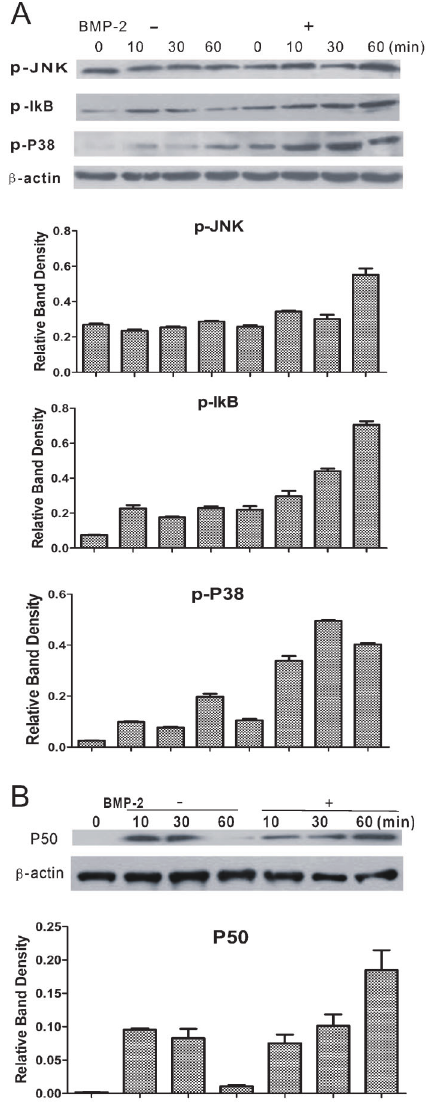
Figure 9. BMP-2 regulates expression of p-JNK, p-IkB, p-P38, and P50. A , RAW 264.7 cells were treated with RANKL and titanium particles for 1 h, then treated or not with BMP-2 at indicated times. p-JNK, p-IkB, and p-P38 were detected by Western blot. B , BMP-2 regulates expression of P50. RAW 264.7 cells were treated with RANKL and titanium particles for 1 h, and then treated with or without BMP-2 at indicated